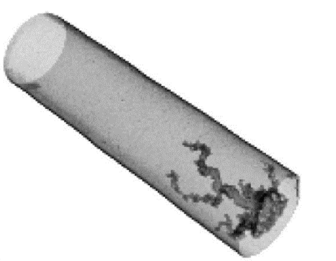
Figure 8. Neutron computed tomography for dissolution of the carbonate by the CO 2 -rich brine (Reprinted with permission from [233]).